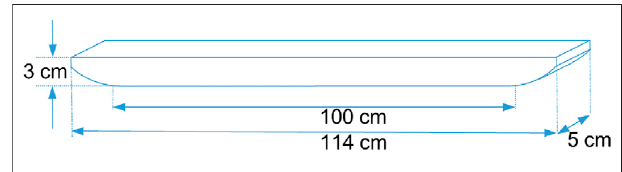
FIGURE 2 | Dimensions of the fl at ski.